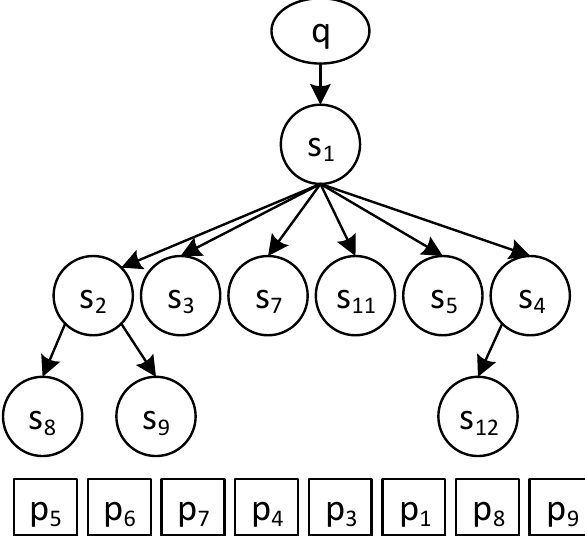
Figure 5. Graph-based expansion